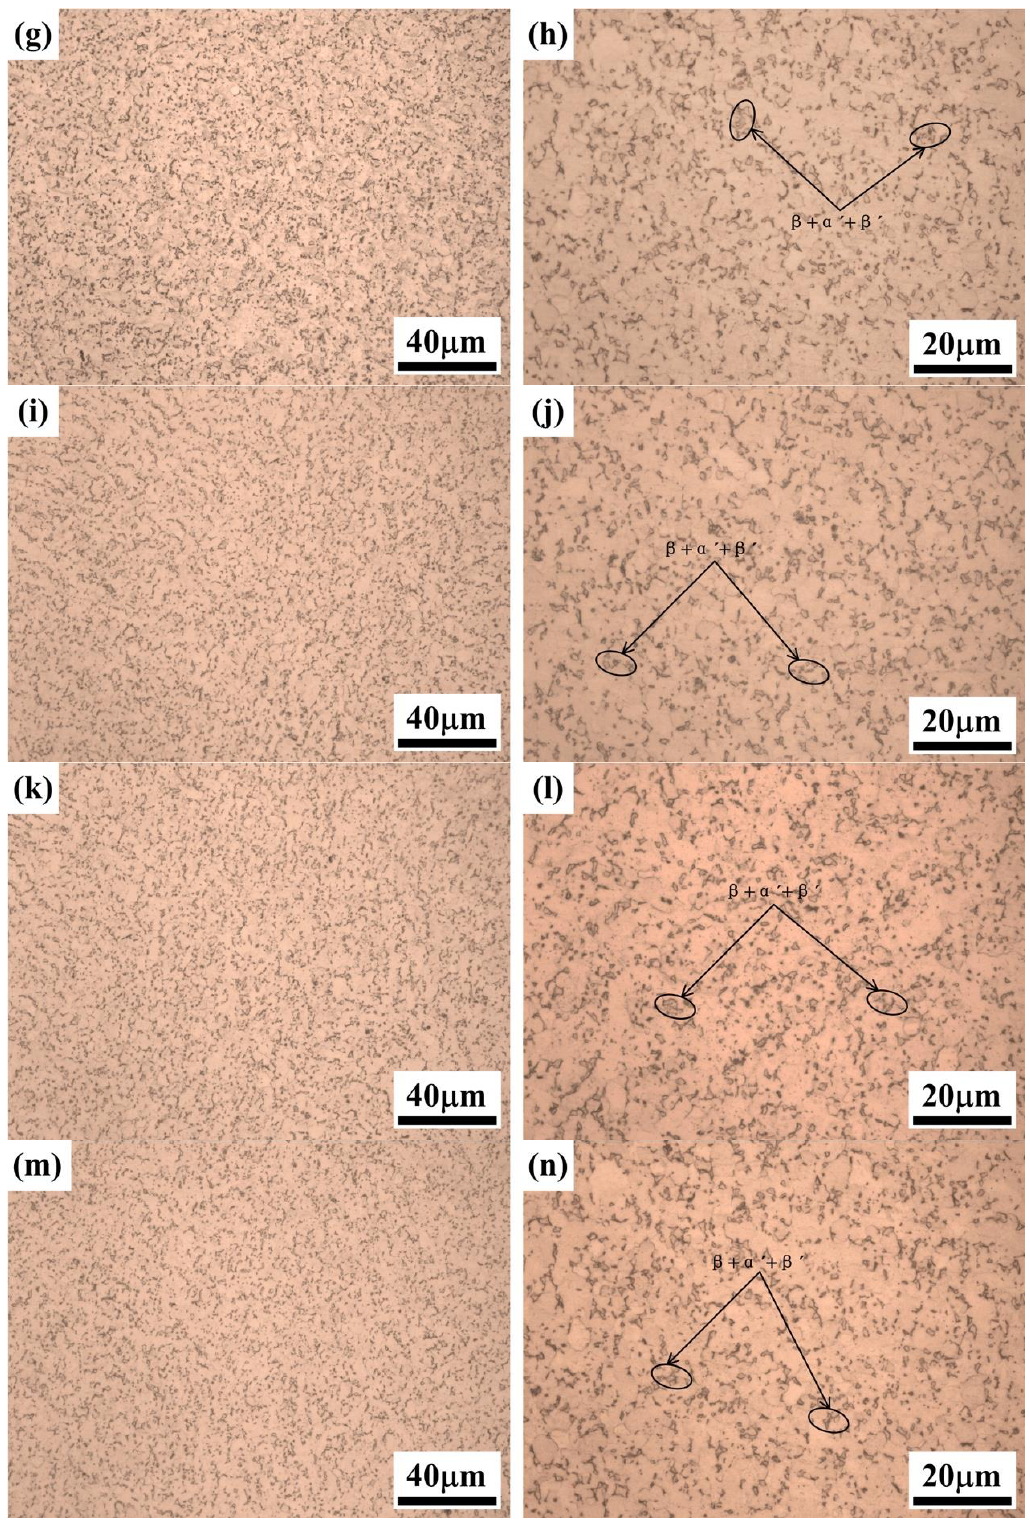
Figure 5. Microstructure of Ti-6Al-4V with different the treatment: ( a ) AT, 500×; ( b ) AT, 1000×; ( c ) ACT1, 500×; ( d ) ACT1, 1000×; ( e ) ACT2, 500×; ( f ) ACT2, 1000×; ( g ) ACT3, 500×; ( h ) ACT3, 1000×; ( i ) ACT4, 500×; ( j ) ACT4, 1000×; ( k ) ACT5, 500×; ( l ) ACT5, 1000×; ( m ) ACT6, 500×; ( n ) ACT6, 1000×.